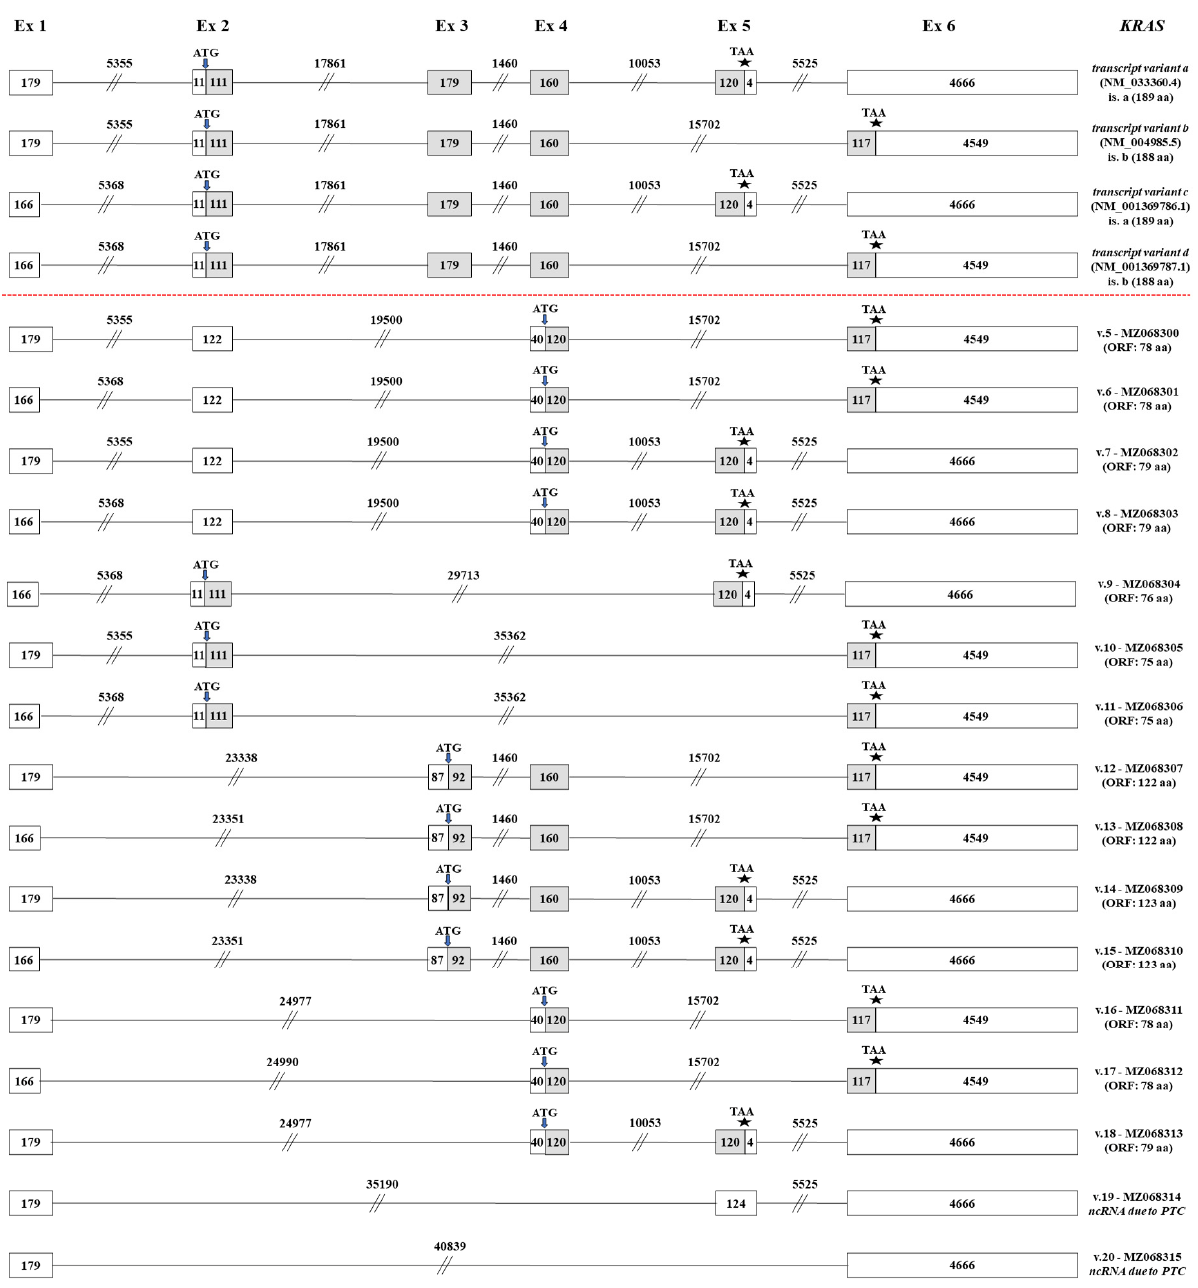
Figure 2. Detailed structural demonstration of the 16 novel KRAS transcript variants ( KRAS v.5 – v.20) identified in the current study. Exons are exhibited as boxes and introns as lines, while the numbers that characterize every box and line correspond to their length in nucleotides. Gray and white boxes represent coding and non-coding regions, respectively. The positions of the ATG and stop codons are pointed out with arrows ( ↓ ) and asterisks (*), accordingly.